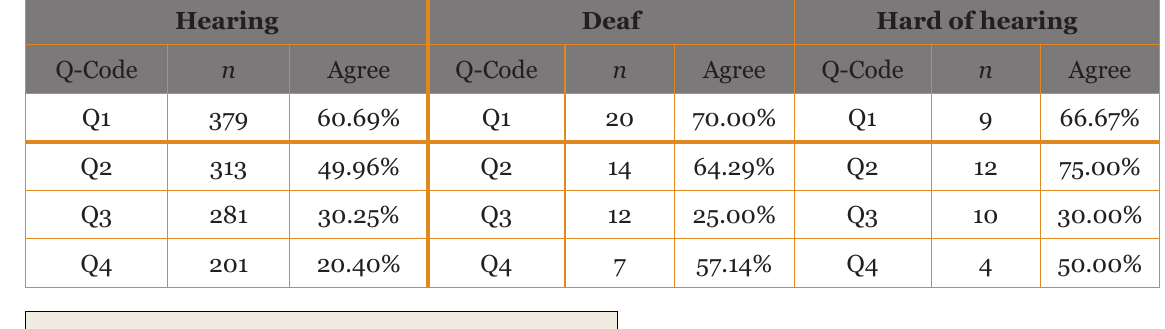
Figure 3. I interacted more with other students than I do in most courses.